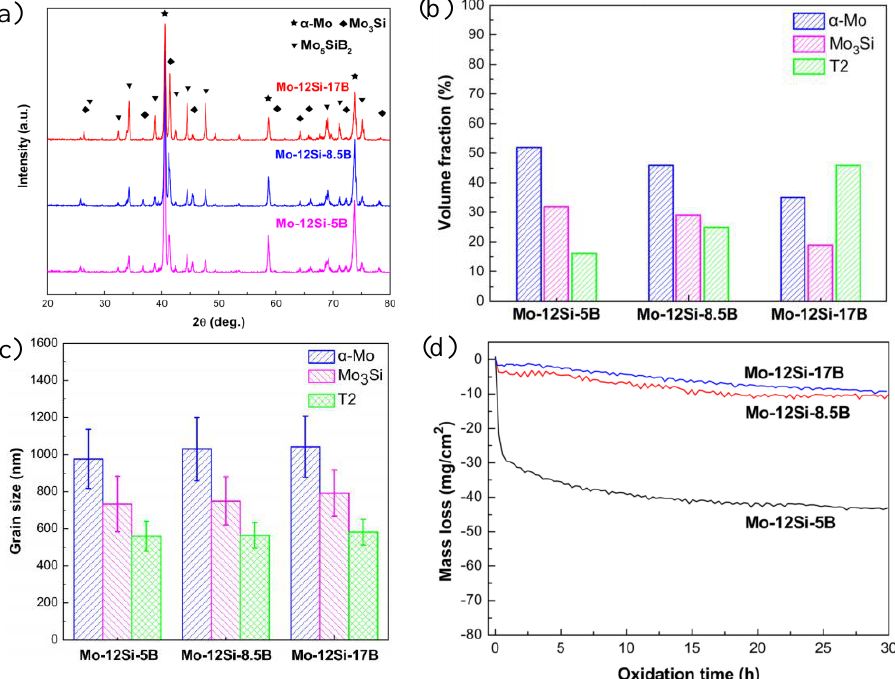
Figure 4. ( a ) XRD patterns of different alloys; ( b ) The volume fraction of different phases in three alloys; ( c ) Average grain size of each phase; ( d ) Oxidation behaviors of various alloys at 1000 °C. Reproduced with permission [44]. Copyright 2019 Elsevier.